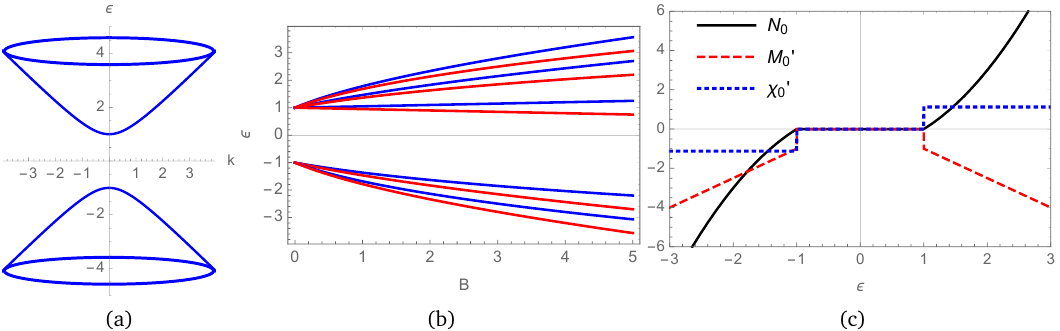
Figure 1: Gapped graphene